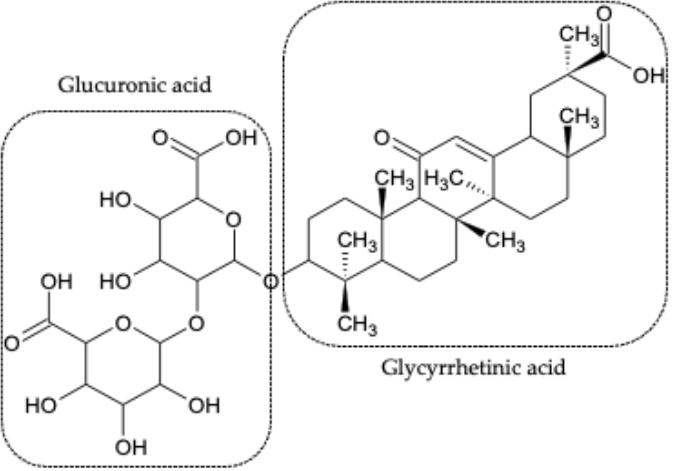
Figure 1. Chemical structure of the triterpenic saponin glycyrrhizic acid (GL) showing the two molecules of glucuronic acid and the molecule of glycyrrhetinic acid (GA).